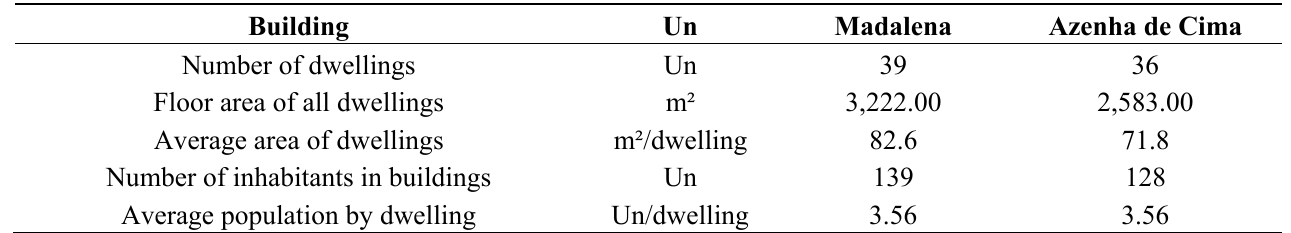
Table 7. Description of areas, dwellings and inhabitants—Madalena vs . Azenha de